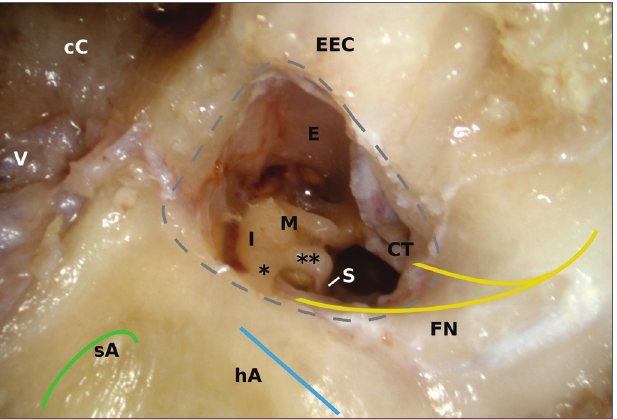
Figura 4. Abordagem mastoidea para o ouvido médio da ovelha (ou- vido direito). O bloco do labirinto ósseo está enclausurado nas células cranianas (cC) contendo tecido adiposo e estrutura cranial occipital e caudal esponjosas. É possível visualizar o eixo lateral (em azul) e